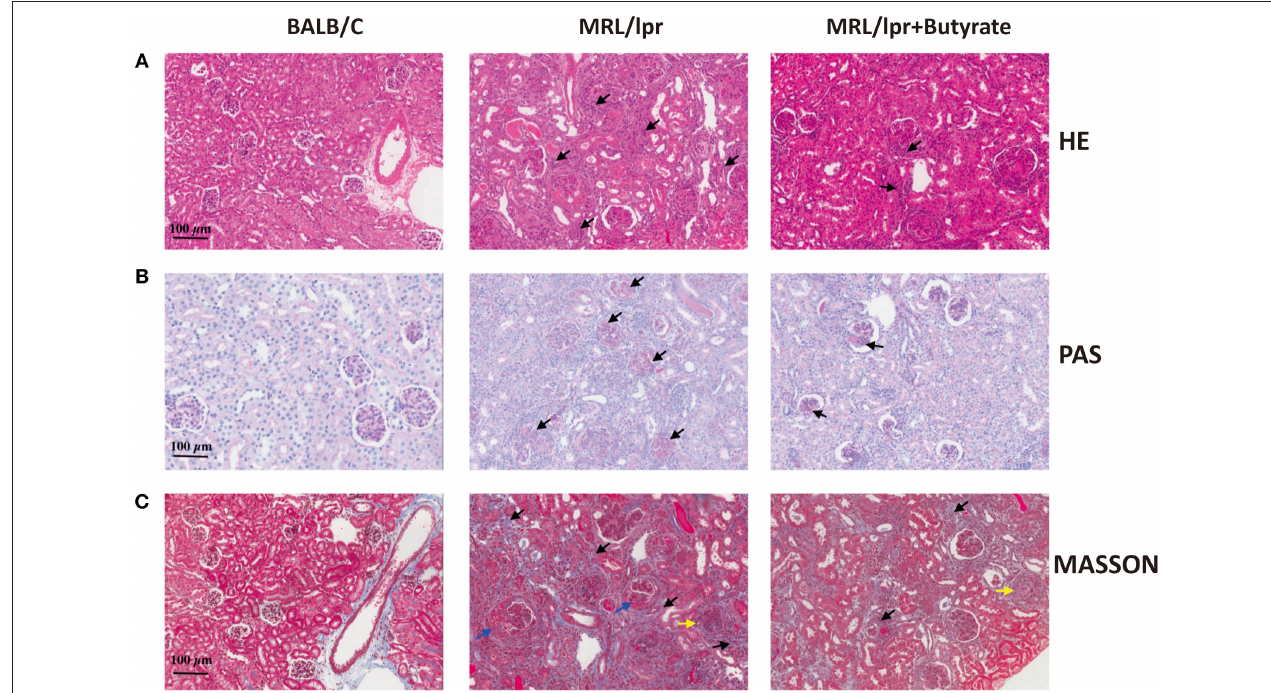
FIGURE 2 | Effects of butyrate treatment improved renal histopathology of MRL/lpr mice at 16 weeks of age. HE staining (A) , PAS staining (B) , and Masson staining (C) . magnification, × 200; Bar equals 100 µ m. Kidney pathological staining showed both proliferation of glomerular mesangial cells and mesangial matrix (arrow in PAS staining) as well as presence of glomeruli sclerosis (yellow arrow in the Masson staining figure) and crescents (blue arrow in the Masson staining figure) were observed in MRL/lpr lupus-prone mice. Lower levels of mesangial cell proliferation, mesangial matrix widening, and inflammatory cell infiltration (arrow in HE staining figure) and interstitial fibrosis (black arrow in Masson staining figure) were observed in the kidneys of mice treated with butyrate.